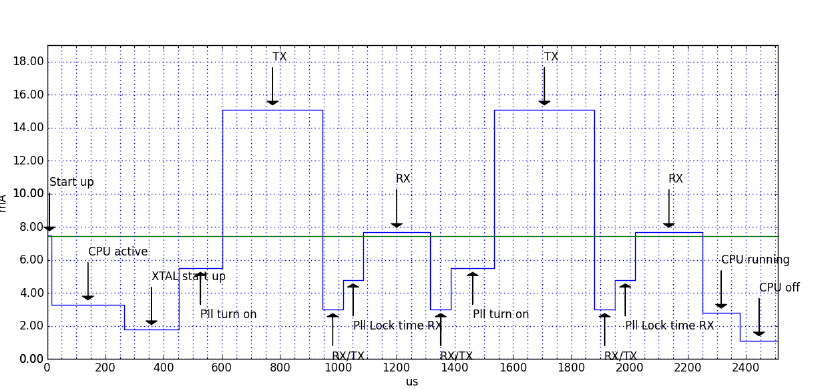
Figure 13. Microcontroller active time.